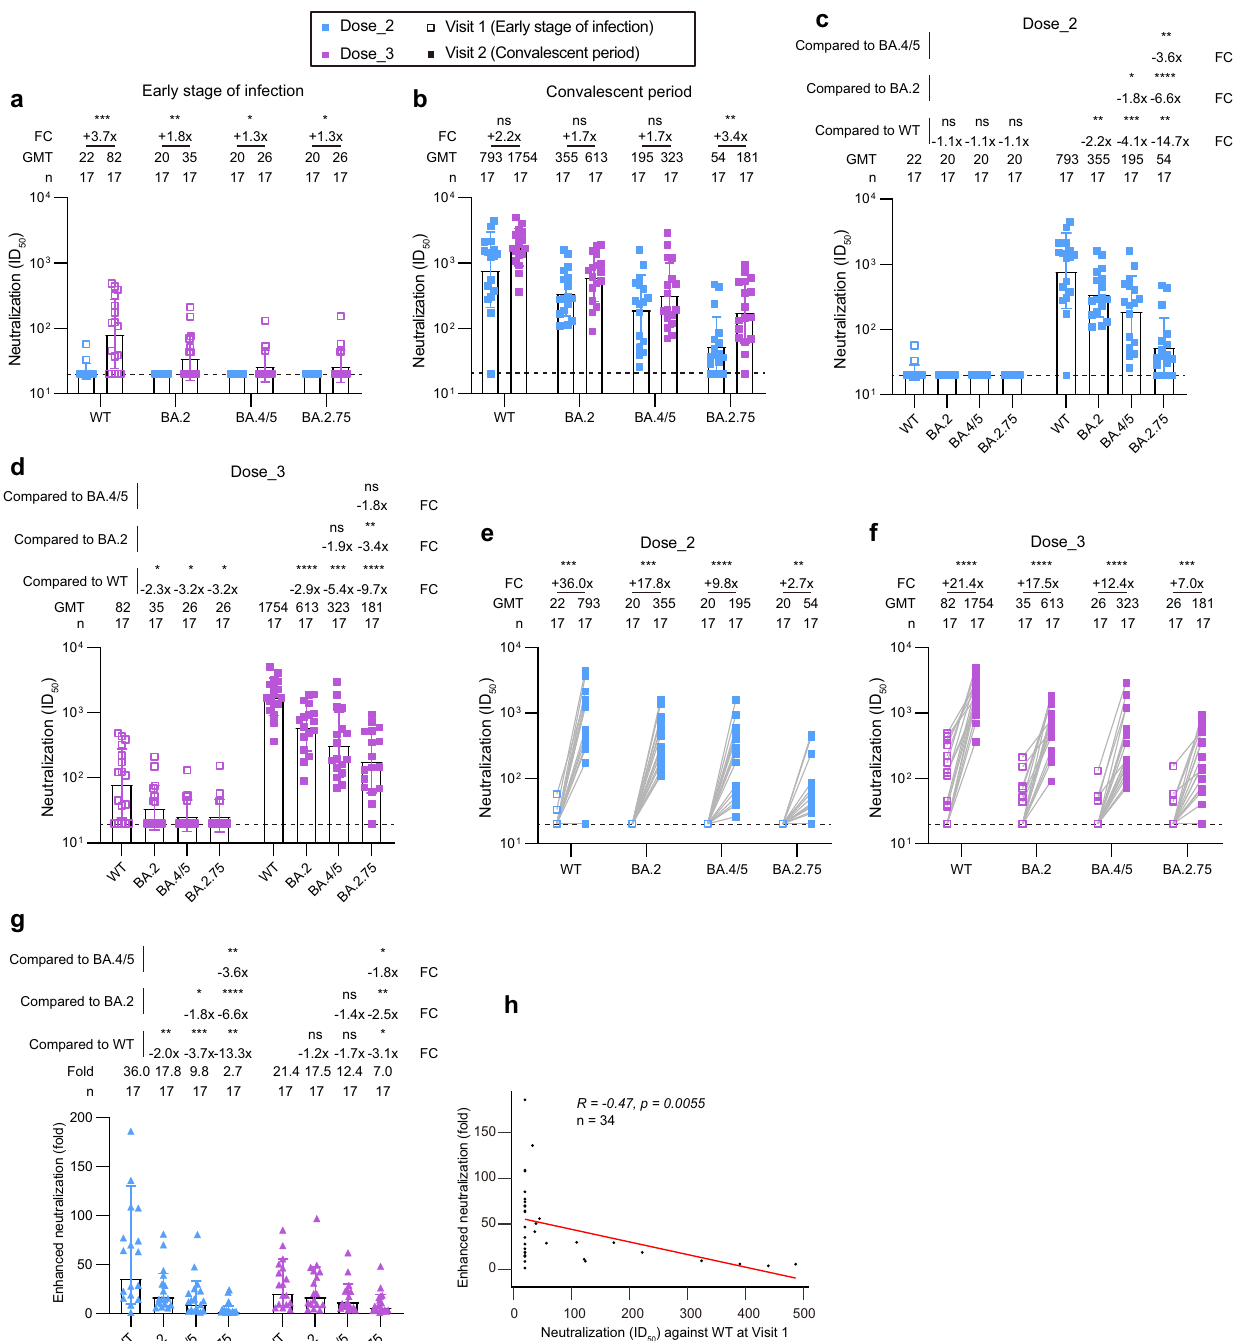
Fig. 2 | Neutralization of SARS-CoV-2 Omicron subvariants by plasma from inactivated vaccine recipients infected with BA.2. a , b Comparison of plasma neutralizing activities in different groups against WT SARS-CoV-2 and Omicron subvariants at Visit 1 (early stage of infection) ( a ) and Visit 2 (convalescent period) ( b ). c , d Neutralization titers against WT SARS-CoV-2 and Omicron subvariants in BA.2 breakthrough infected individuals with 2-dose ( c ) and 3-dose ( d ) inactivated vaccines. e , f Enhancement effects of neutralization against WT SARS-CoV-2 and Omicron subvariants by BA.2 breakthrough infection in 2-dose ( e ) and 3-dose ( f ) group. g Fold change in the enhanced neutralization of WT SARS-CoV-2 and Omi- cron subvariants by BA.2 breakthrough infection. h Correlation analysis between ID 50 values against WT SARS-CoV-2 at Visit 1 and fold changes of enhanced neu- tralization in the 34 BA.2 breakthrough infected individuals. Perfect- fi t correlation line was included on the plot. The non-parametric Spearman ’ s correlation